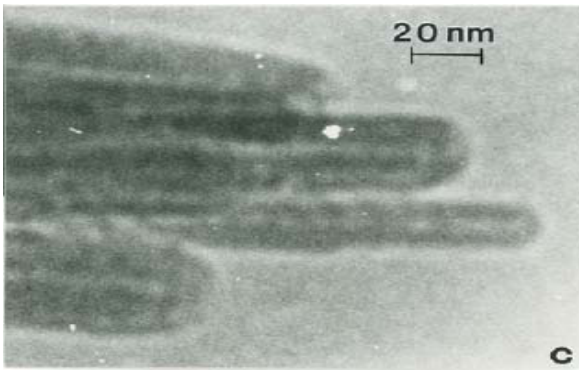
Figure 4: TEM bright-field images of chrysotile asbestos nanotube bundles (From Murr and Soto